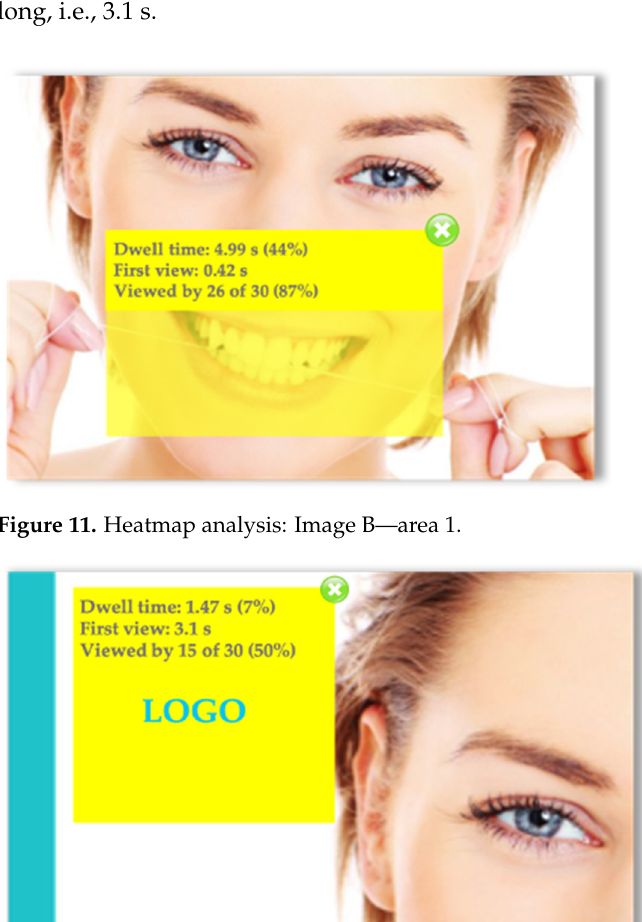
Figure 10. Heatmap analysis: Image A—area 2.